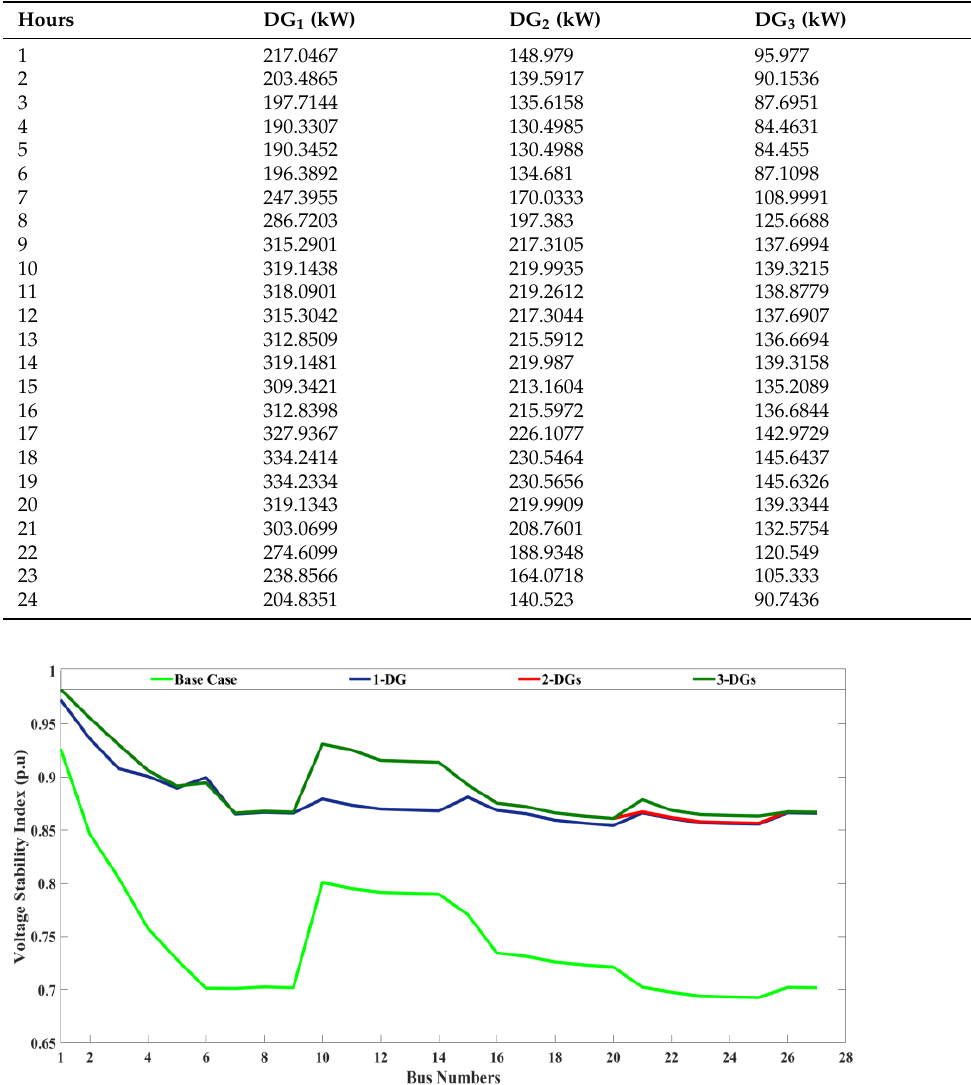
Table 5. DG sizes under dynamic load profile without considering uncertainties.